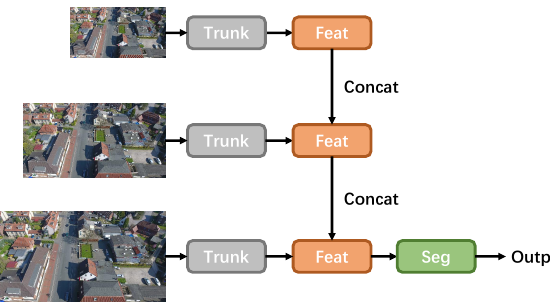
Figure 2. Architecture of the multi-scale dilation net. Features are aggregated from coarse to fine scales with concatenation.